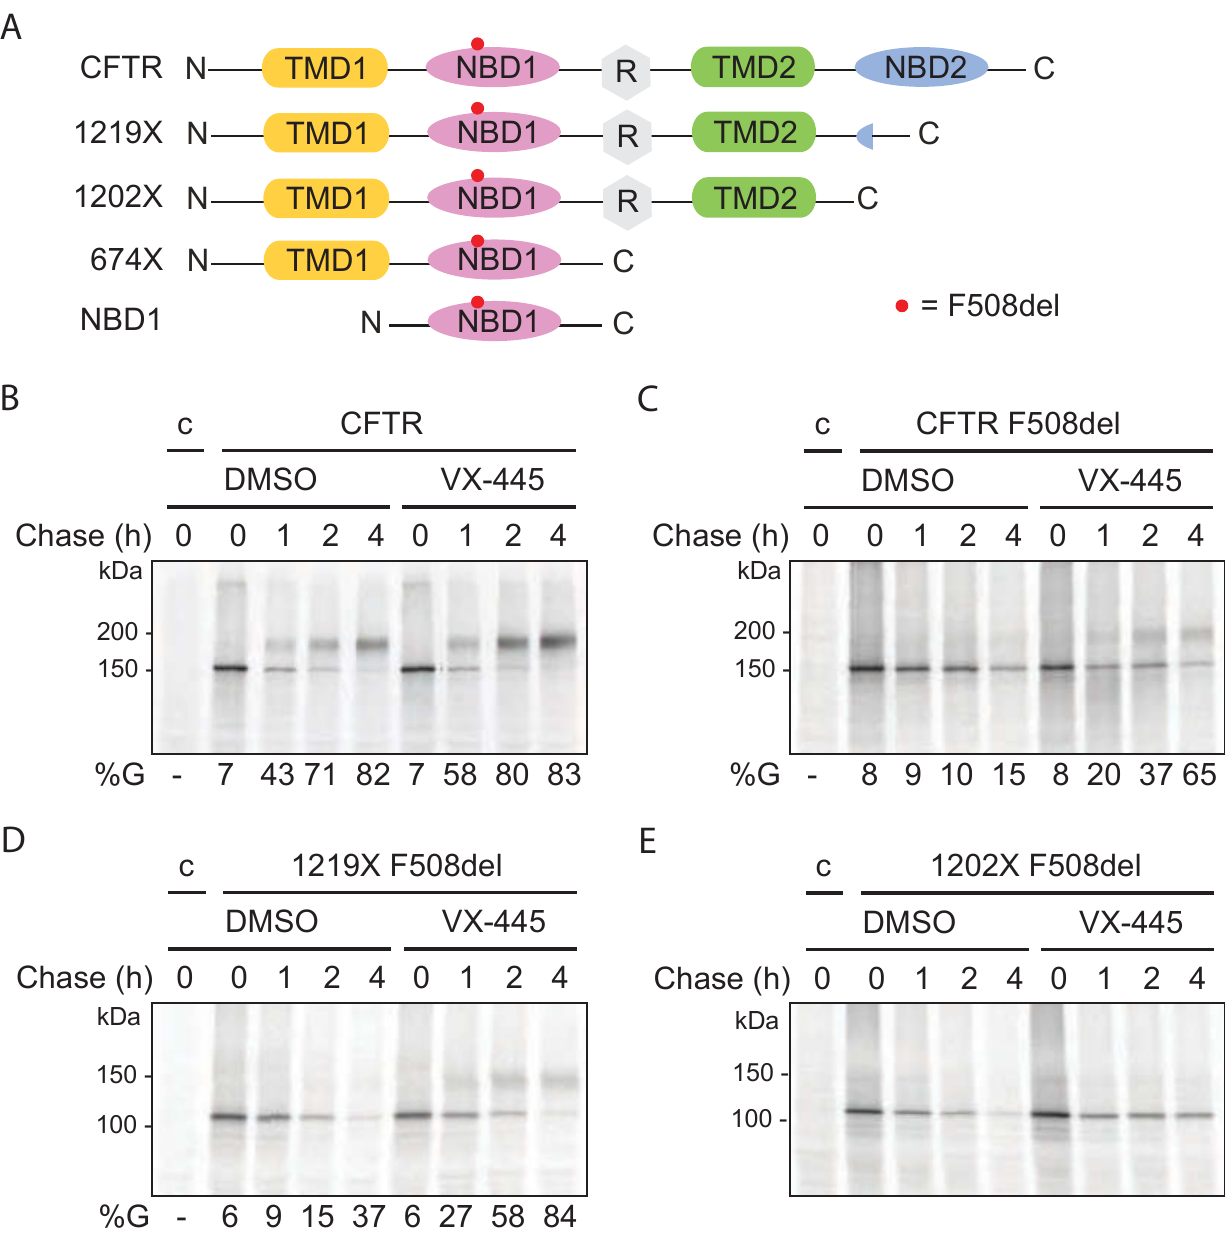
Quantifications are in Figure